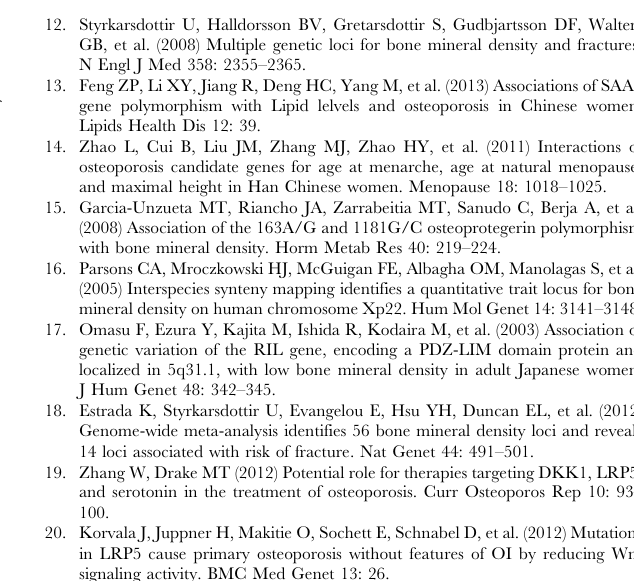
Table S1 Allele and genotype frequency of all SNPs